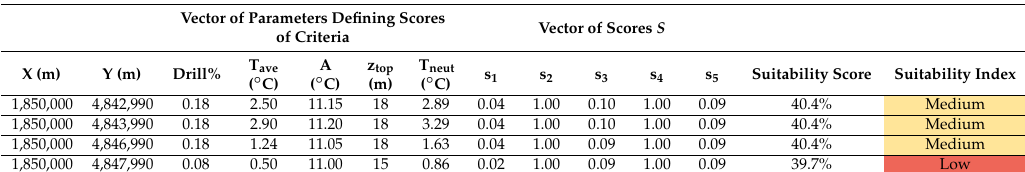
Table 12. MCDA database used to define the Suitability Index (example grid nodes located in Andorra; colours of results cells compliant with colours used in Figure 8—see online version). Vector of Parameters Defining Scores of Criteria